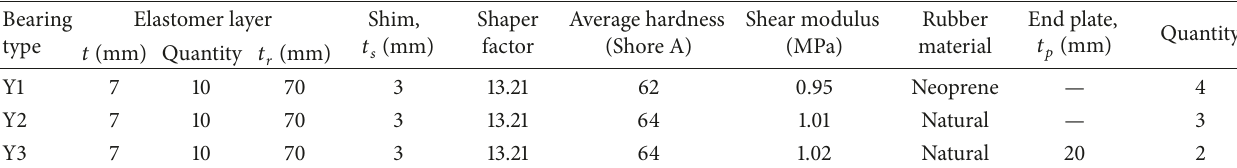
Table 1: Test specimen characteristics.